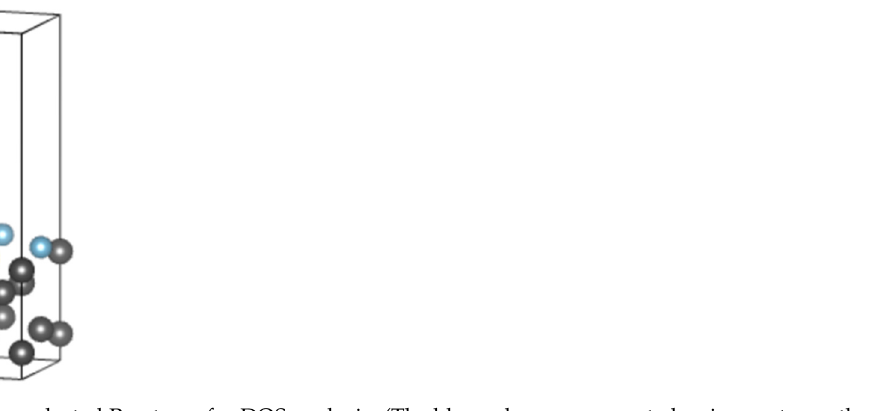
( b ) Figure 7. Local electrostatic potential energy i n the Z d irection of different systems (Pu-Al system ( a ) δ -Pu system ( b )). 3.3. Density of States Analysis Density of states (DOS) is the number of states (number of vibration modes) per unit frequency interval. Further calculational analysis of the density of states can give the char- acteristics of electronic states intuitively and provide further study of the interaction be- tween atoms. To further investigate the microscopic interactions between the H atom and surface atoms of the Plutonium-Aluminum system and pure plutonium system, the most stable configuration for H adsorption is selected, and the density of states is calculated and analyzed. The central plutonium atom is selected, Figure 8. Since the Pu/6s and Pu/6p are close to the nucleus, Figure 9 shows that the density of states energy of Pu/6s and Pu/6p is much lower than the Fermi level, which does not be- long to the valence electrons and does not participate in bonding. Near the Fermi level,